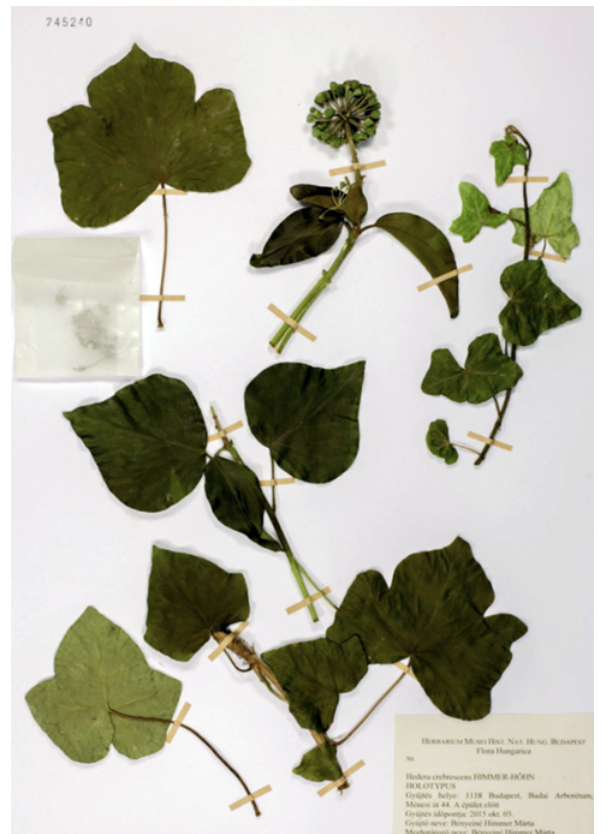
Figure 1 The holotype specimen of Hedera crebrescens (Bényei-Himmer et al.,